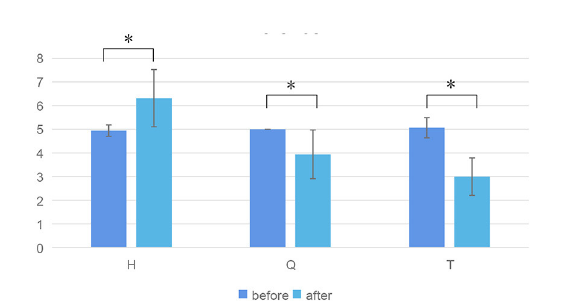
FIGURE6 Valence score before and after three kinds of emotional stimuli. * represents significant difference between the two groups ( p ≤